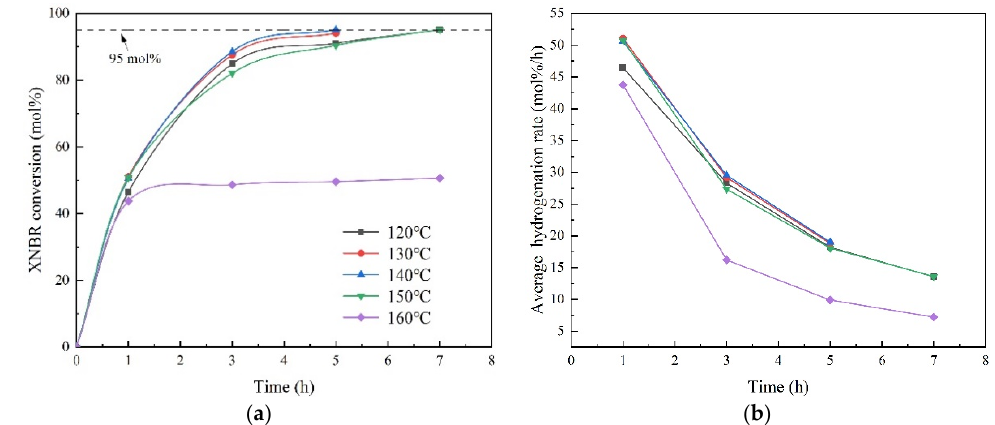
Figure 5. The XNBR conversion ( a ) and average hydrogenation ( b ) rates under different reaction temperatures.